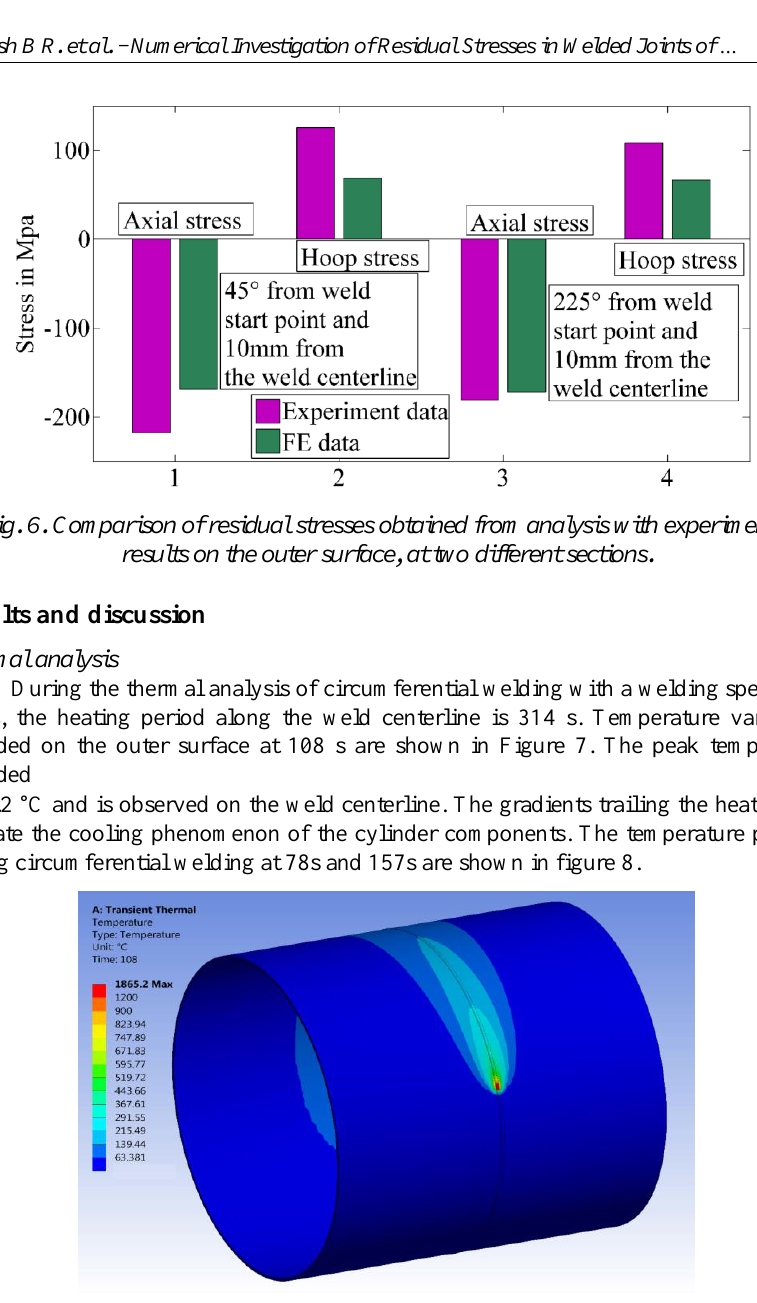
Fig. 7. Temperature profile on the outer surface during circumferential